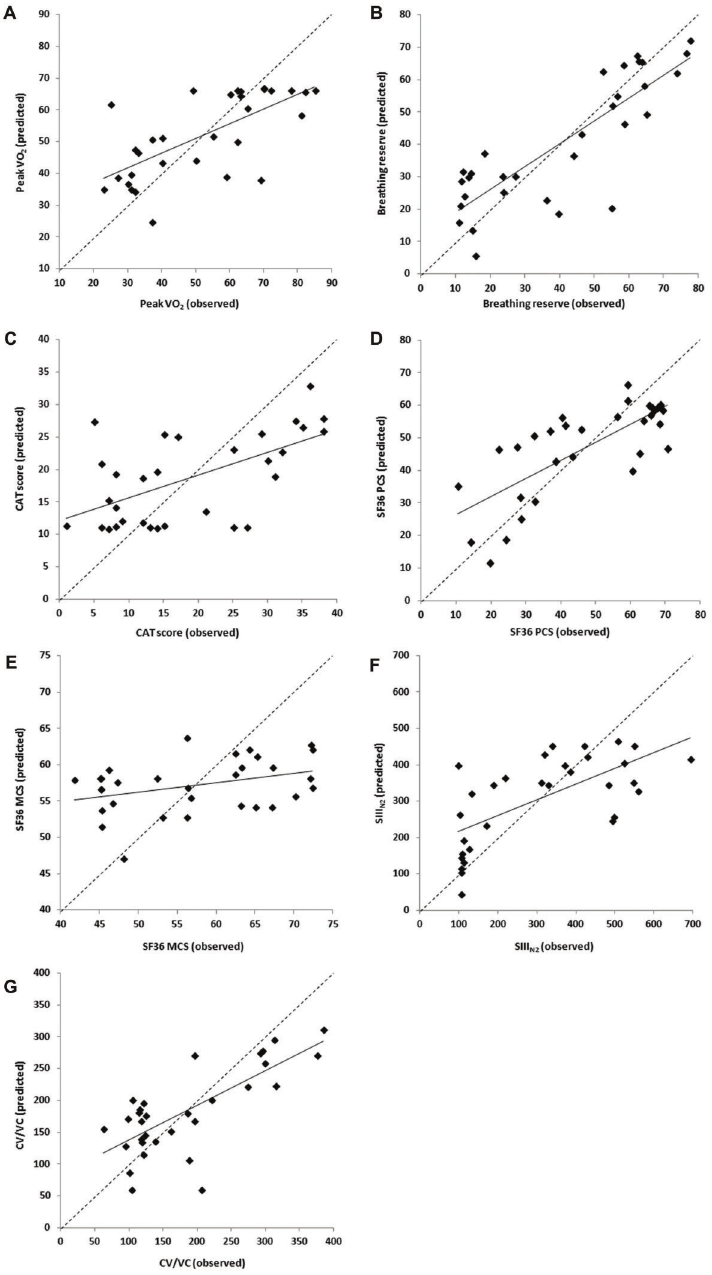
Figure 2. Calibration plots of the observed versus predicted values. A , Analysis of the multiple linear regression models for peak oxygen uptake (peak VO 2 ); B , breathing reserve; C , COPD assessment test (CAT); D , 36-Item Short Form Health physical component summary (SF36 PCS); E , 36-Item Short Form Health Survey-mental component summary (SF36 MCS); F , phase III slope of nitrogen single- breath washout (SIII N2 ); and G , closing volume/vital capacity